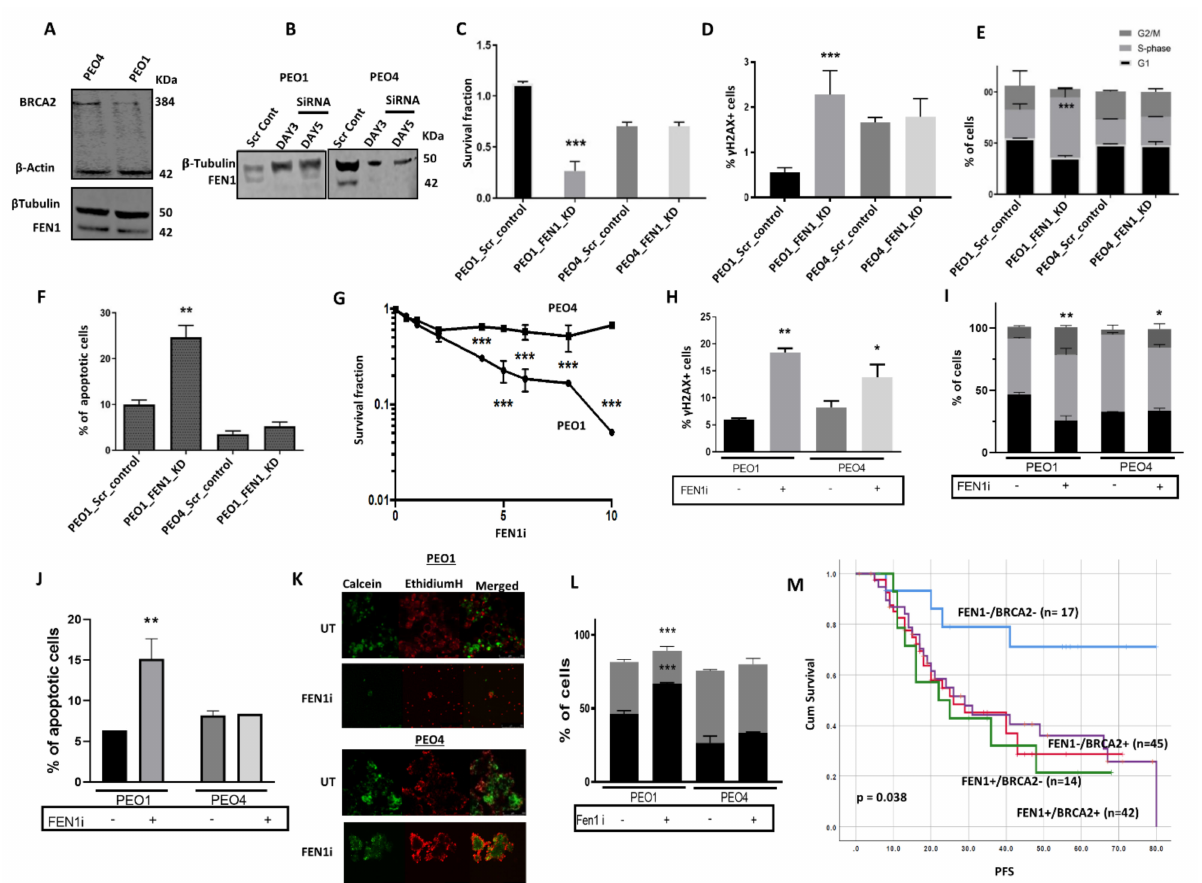
Figure 5. ( A ) Western blot showing BRCA2 and FEN1 expression in PEO1 and PEO4 cells. ( B ) Western blot showing FEN1_KD in PEO1 and PEO4 cells. ( C ) Cell viability was assessed by clonogenic assay in PEO1 or PEO4 control or FEN1_KD cells. ( D ) γ H2AX analysis by flow cytometry in PEO1 or PEO4 control or FEN1_KD cells. ( E ) Cell cycle progression in PEO1 or PEO4 control or FEN1_KD cells. ( F ) AnnexinV analysis by flow cytometry PEO1 or PEO4 control or FEN1_KD cells. ( G ) Clonogenic assay showing FEN1 inhibitor sensitivity in PEO1 and PEO4 cells. ( H ) Quantification of γ H2AX nuclear fluorescence by ImageJ software in FEN1 inhibitor-treated PEO1 and PEO4 cells. ( I ) Cell cycle analysis by flow cytometry in FEN1 inhibitor-treated PEO1 and PEO4 cells. ( J ) Annexin V analysis by flow cytometry in FEN1 inhibitor-treated PEO1 and PEO4 cells. ( K ) FEN1 inhibitor sensitivity in PEO1 and PEO4 spheroids. ( L ) Quantification of dead and living cells in FEN1 inhibitor-treated PEO1 and PEO4 spheroids. All figures are representative of 3 or more experiments. ( M ) Kaplan-Meier curve for FEN1-BRCA2 co-expression and progression-free survival (PFS) in ovarian cancer. * = p value < 0.05, ** = p value < 0.01, *** = p value <